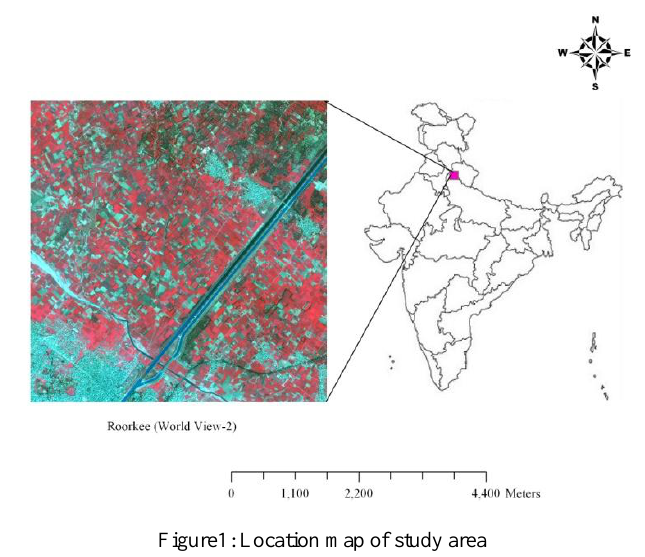
Figure1: Location map of study